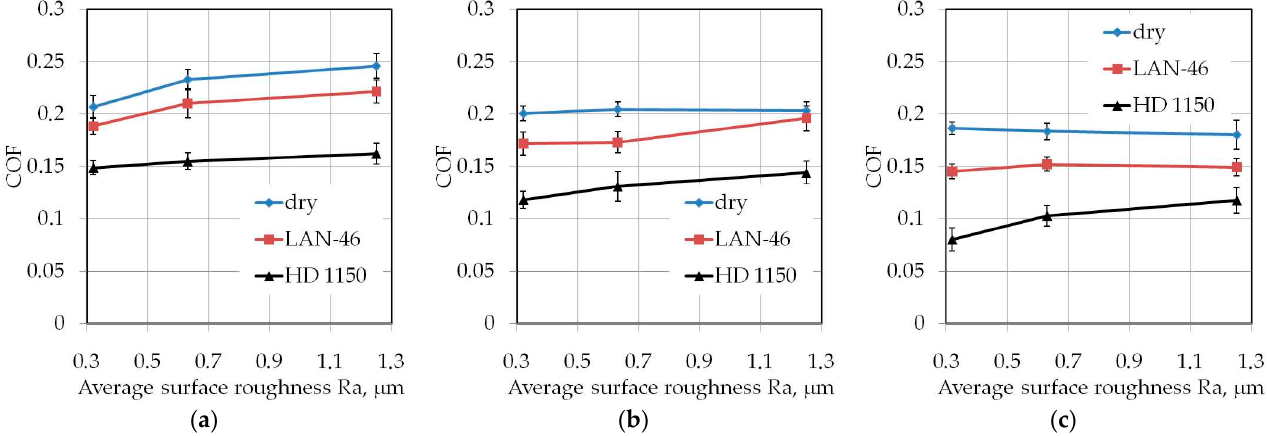
Figure 11. Effect of countersample roughness on the value of COF for specimens with a width of w = 14 mm cut along the rolling direction (orientation 0°): ( a ) h = 6 mm, ( b ) h = 12 mm, ( c ) h = 18 mm.